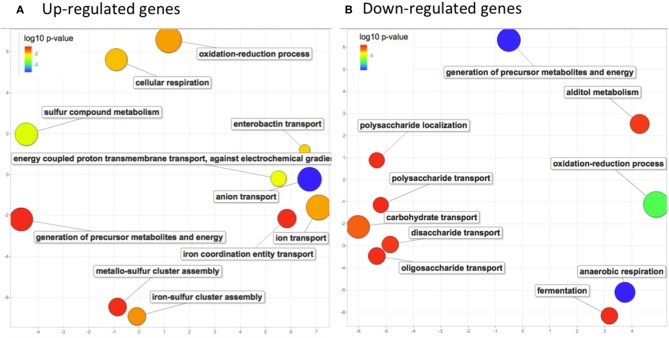
Biological process GO terms enrichment analysis in response to imipenem in E. coli (pBIC-1a). Scatterplots showing the non-redundant up (A) and down-regulated (B) GO terms significantly enriched after imipenem exposure. GO enrichment was determined by PANTHER web application and GO terms significantly enriched with adjusted p-values under 0.05 were summarized by using REVIGO. Only chromosomal genes were analyzed. The axes have no intrinsic meaning, similar GO terms remain close together in the plot. The bubble size indicates the frequency of the GO term. (A) upregulated genes revealed enrichment in energy production processes (aerobic respiration and electron transport chain), in ion transport and in cluster Fe-S assembly. (B) Downregulated genes were mostly associated to anaerobic respiration, generation of precursors of metabolites and energy. Both up and down-regulated genes summarization revealed an enrichment in oxidoreduction process.